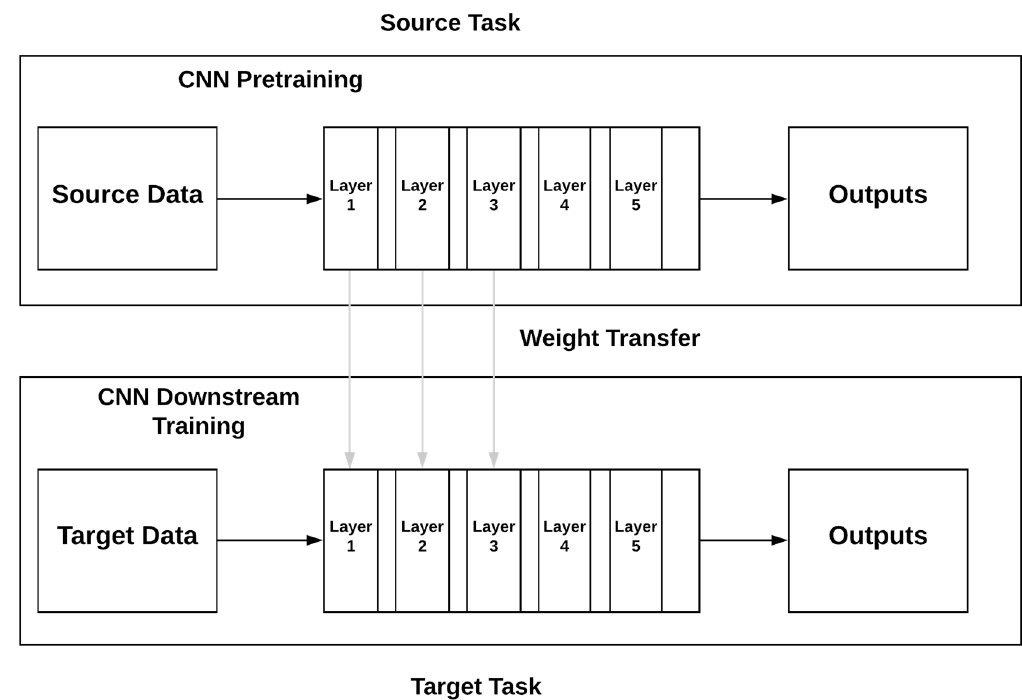
Figure 4. A standard transfer learning framework. The CNN is pretrained using the source data, and then the weights from the first layers are reused when training on the target data.